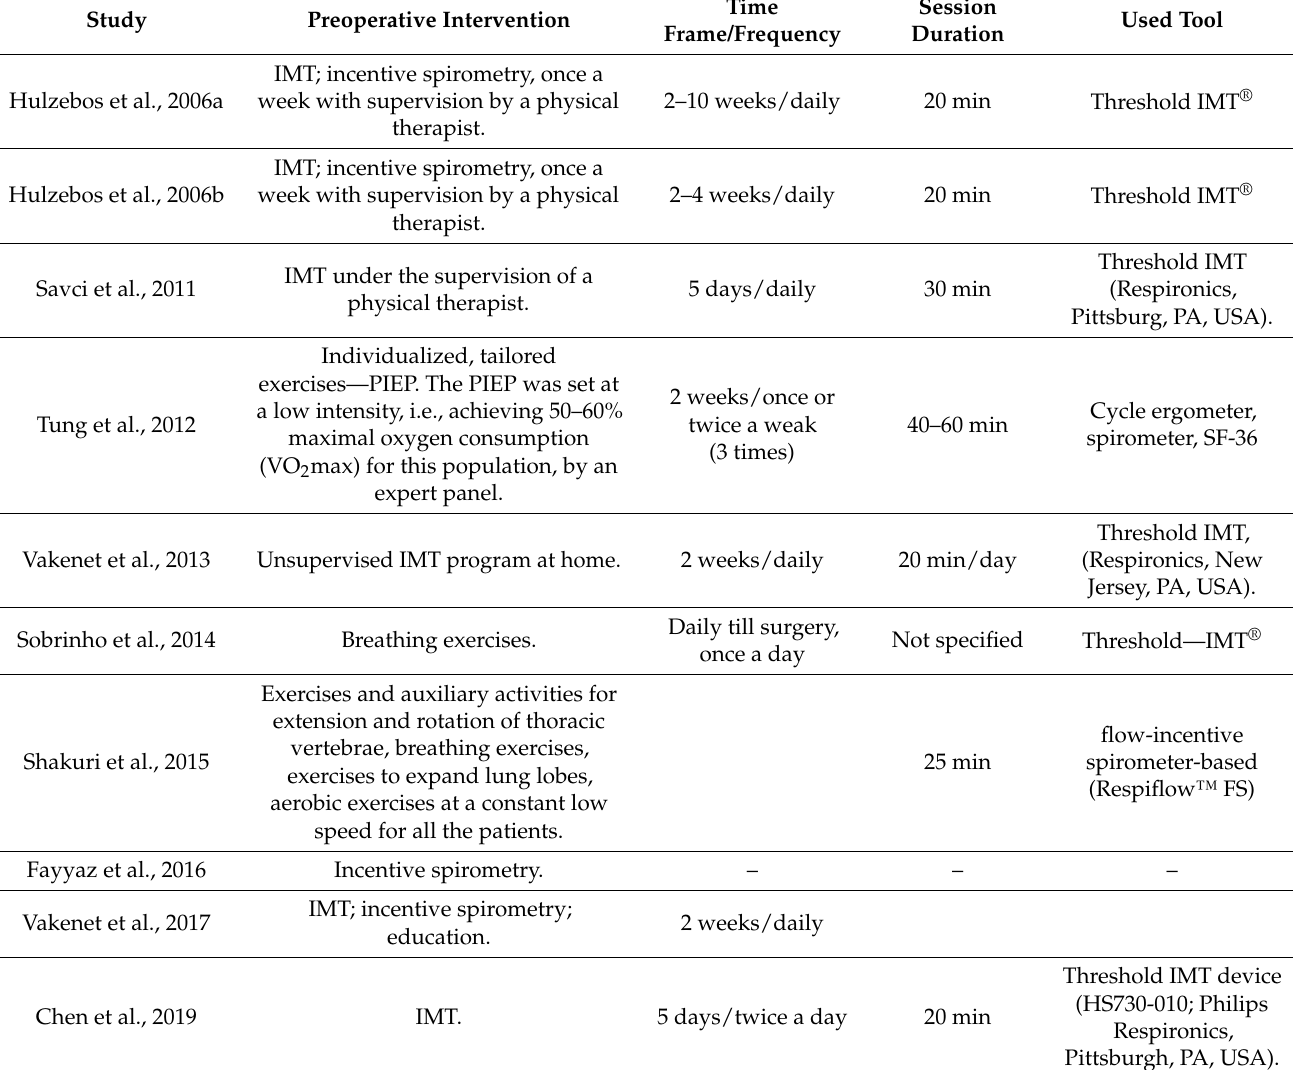
Table 4. The type and description of interventions in the included